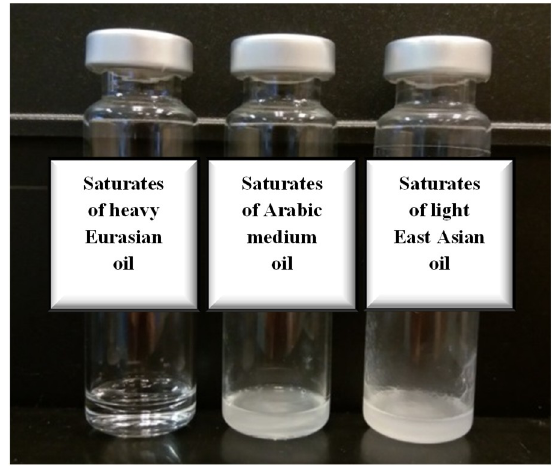
Figure 2. Saturate fractions of heavy Eurasian oil ( left ), Arabic medium oil ( middle ) and E. Asian light oil ( right ).